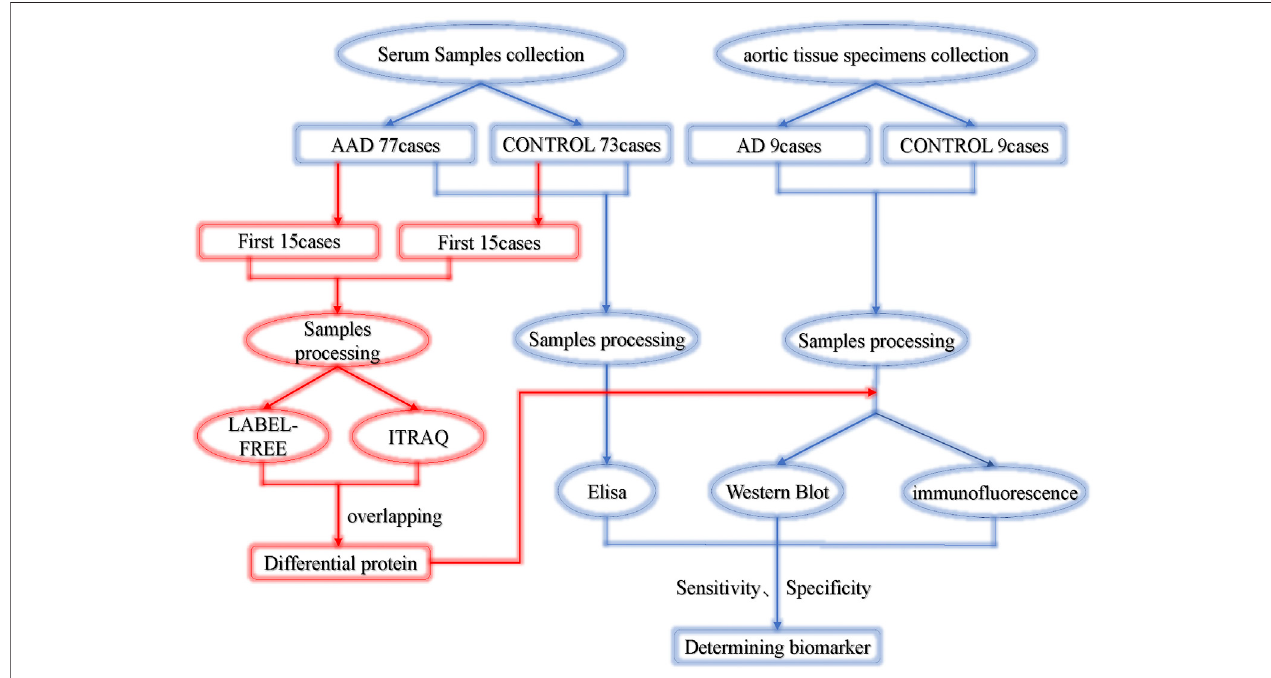
FIGURE 1 | Experimental design. AAD, acute aortic dissection; ACS, acute coronary syndrome.